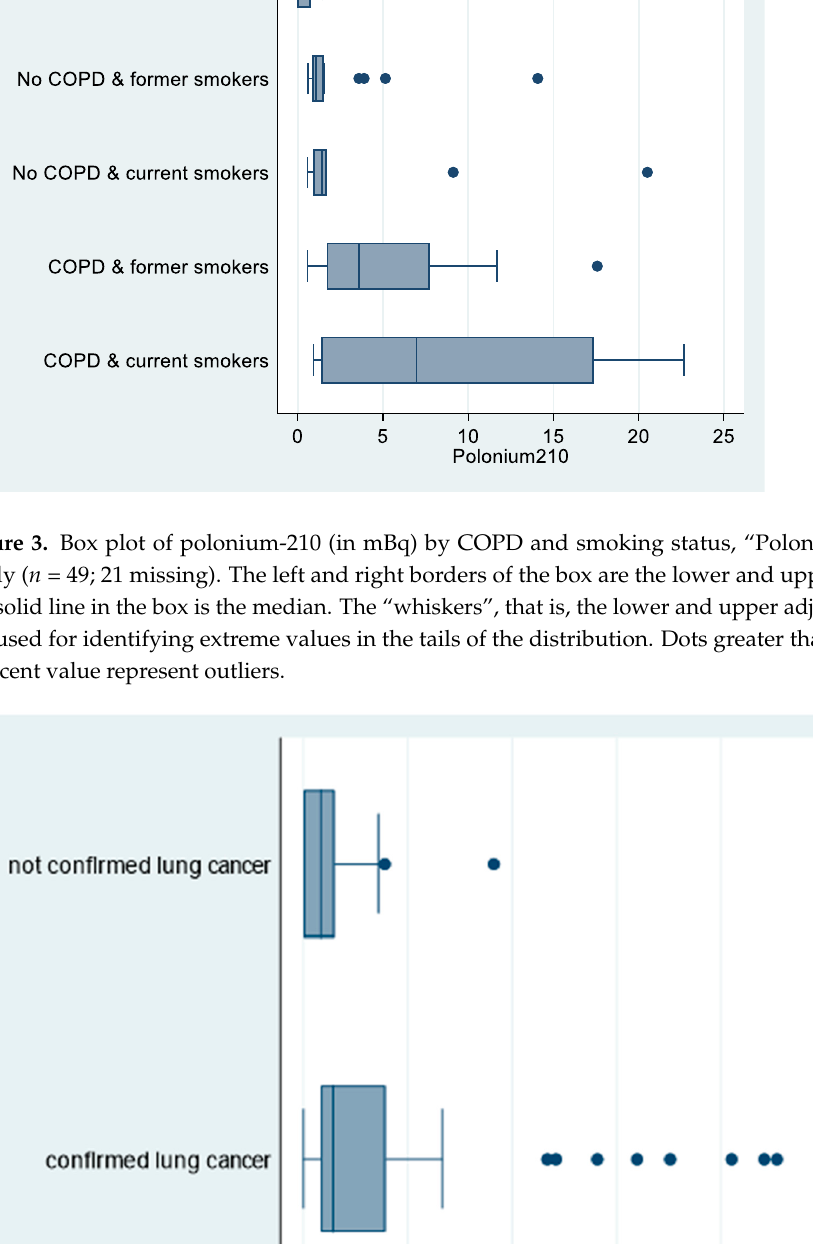
per adjacent values are used for identifying extreme values in the tails of the distribution. Dots